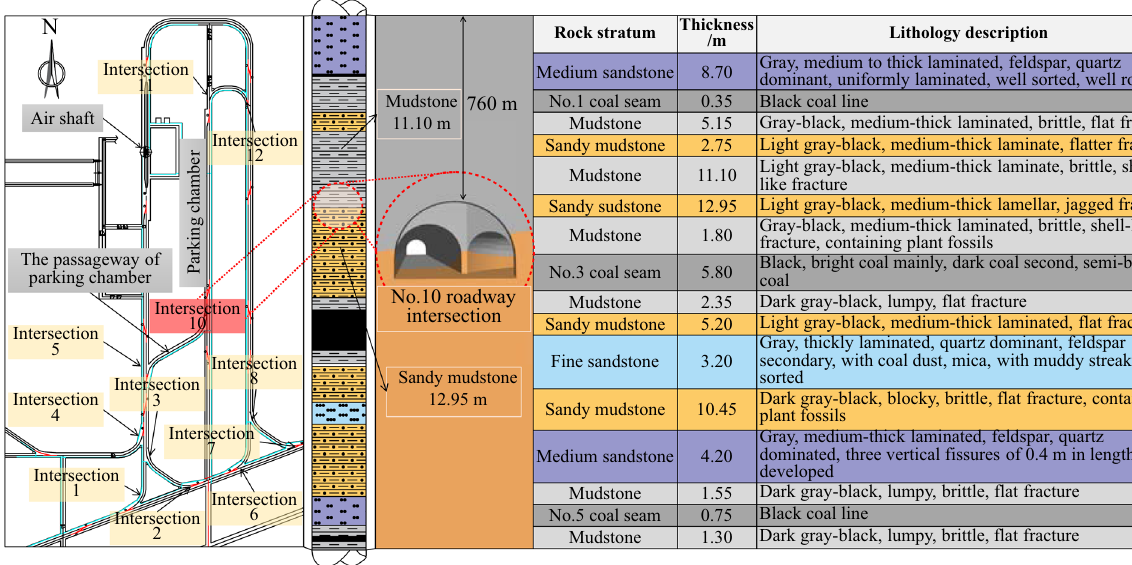
Fig. 1 Comprehensive histogram of the stratum at the intersection of the